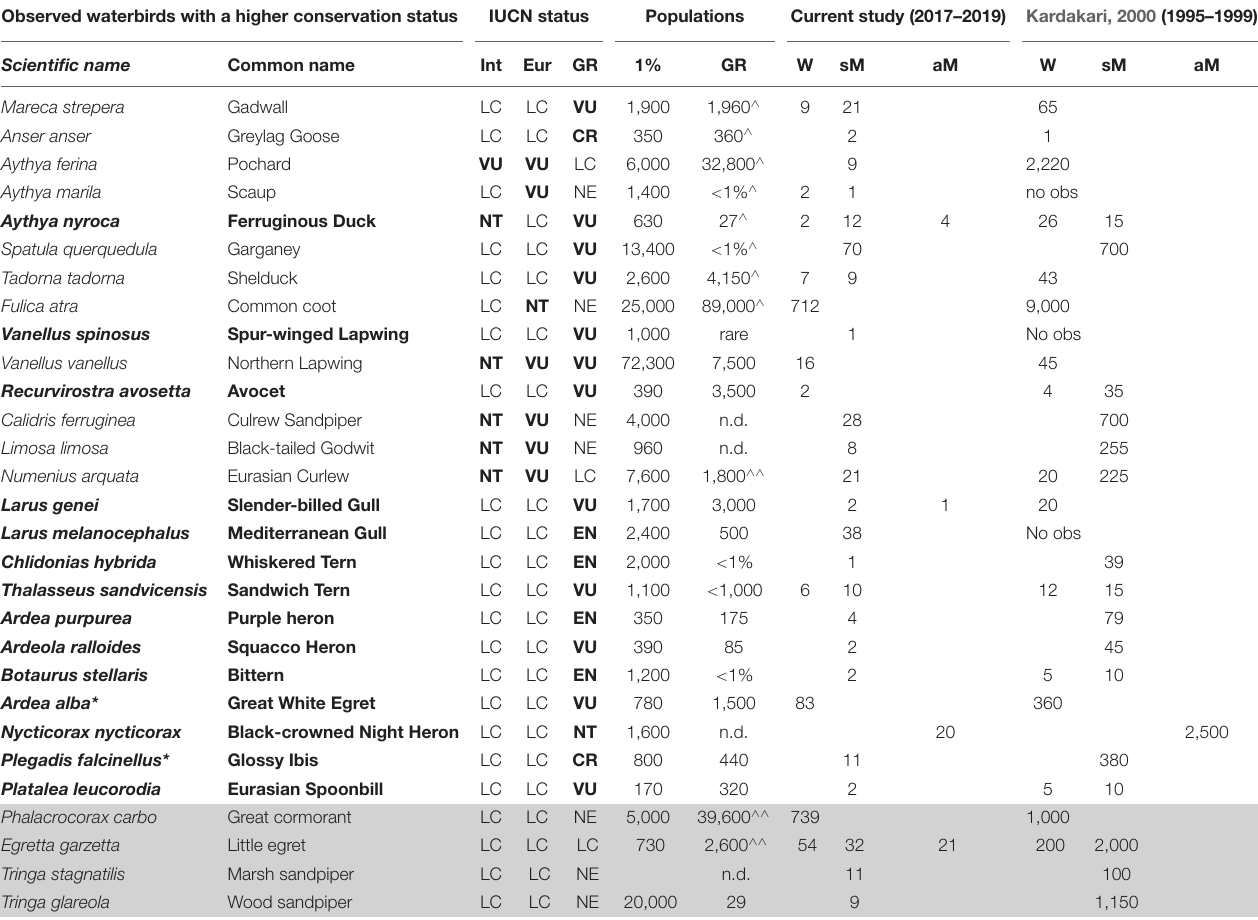
TABLE 6 | Observed waterbirds in GLw-Natura2000, which are threatened at International (Int), European (EU) and Greek (GR) level, and additional IBA/SPA species of concern (gray part of the table). Observed waterbirds with a higher conservation